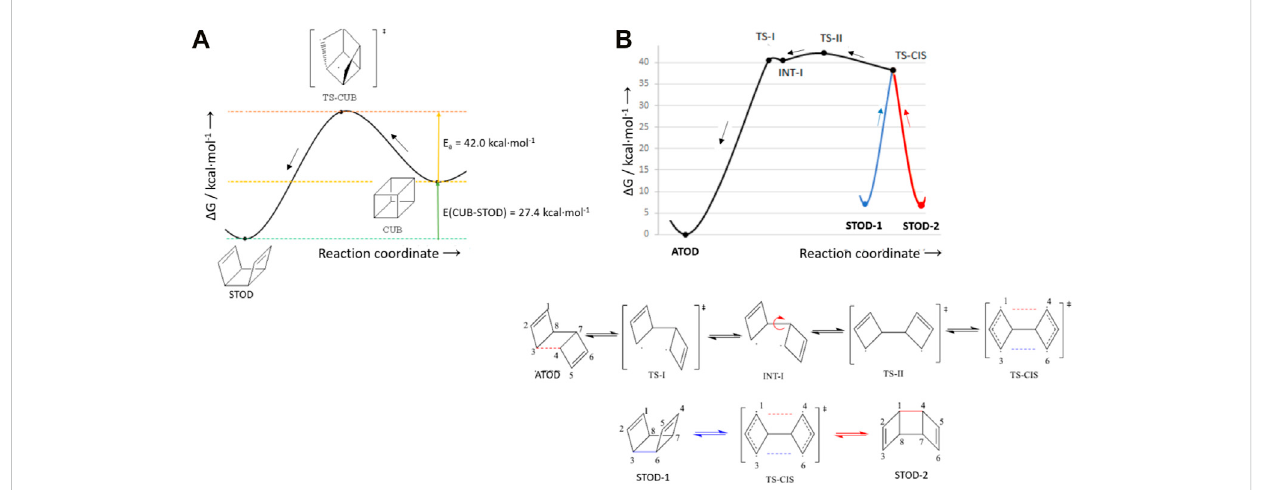
FIGURE 6 Two steps to release, on the ground state, the energy stored by CUB: (A) CUB → STOD through the transition state TS-CUB and (B) STOD → ATOD through a diradical intermediate